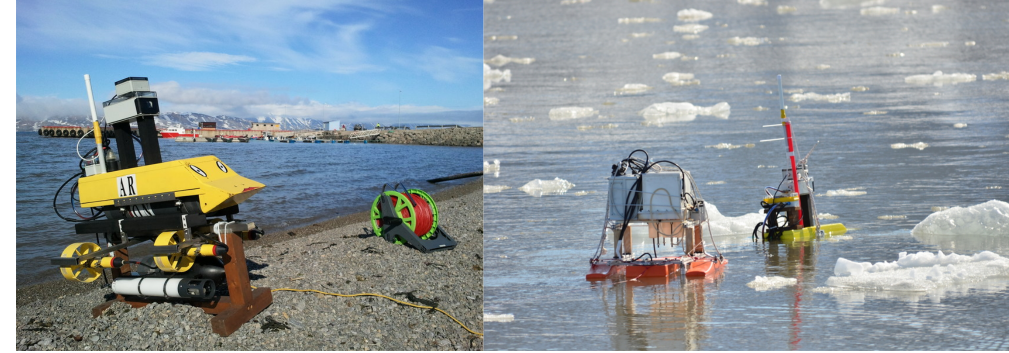
Figure 7. Shark USSV: Preliminary trials in Ny-Ålesund.